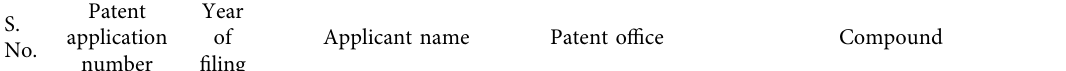
Table 1: Patent fled for xanthine derivatives in last twenty years (2002–2020).